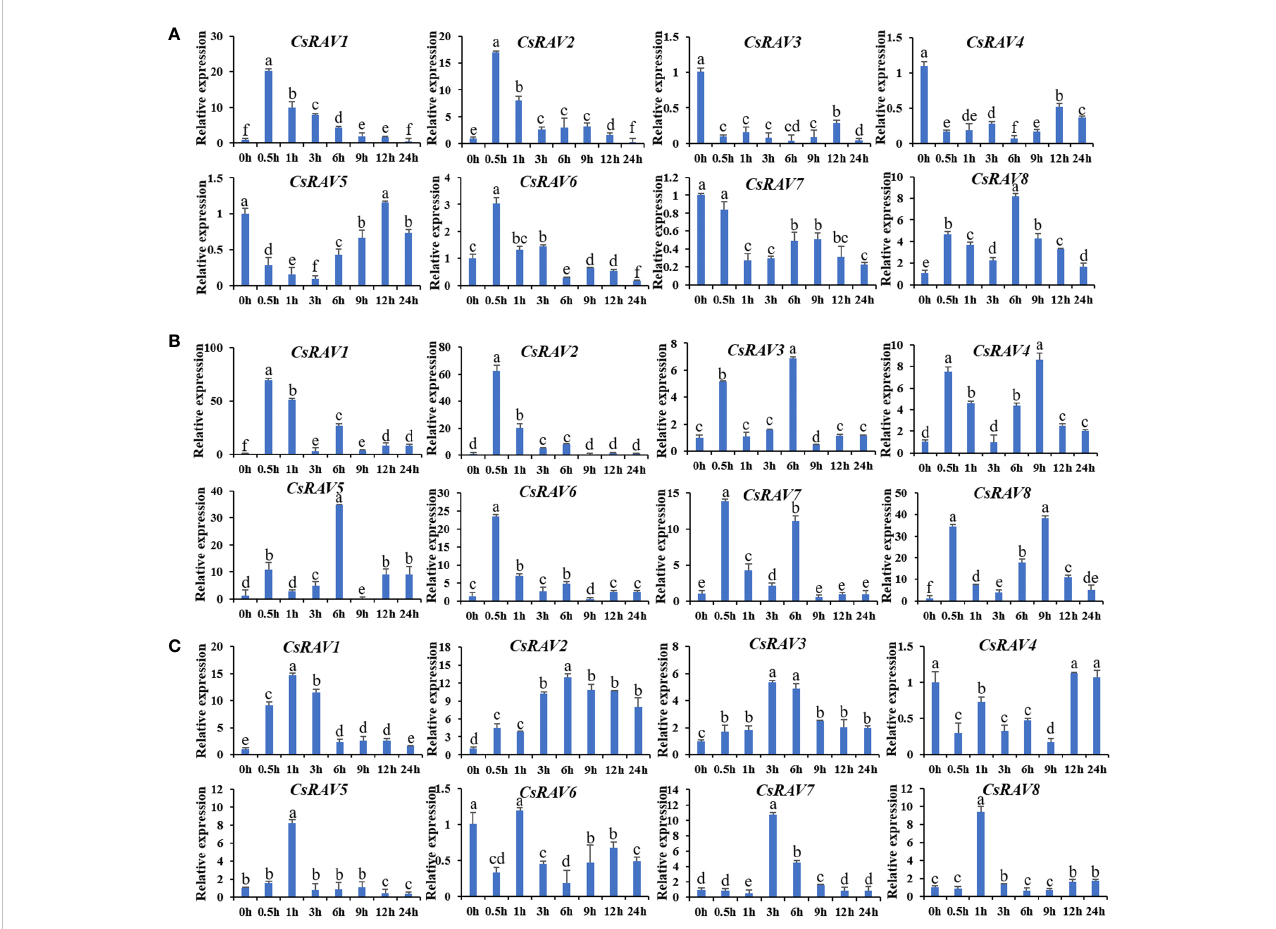
FIGURE 5 Relative expression of CsRAV genes in cucumber seedlings treated with NaCl, ABA and low temperature. QRT-PCR was used to analyze the expression levels of CsRAVs under NaCl (100 mM) (A) , ABA (100 m M) (B) and 4°C (C) . Using cucumber b -actin gene as an internal control, three biological replicates were used to analyze gene expression. Error bars were the standard errors (SE). Different lowercase letters represented signi fi cant differences (P <